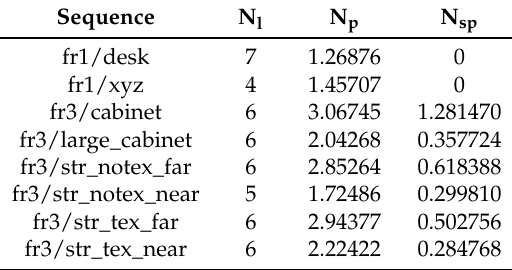
Table 4. The number of plane landmarks and the average number of observed planes on TUM RGB-D dataset. N l denotes the number of plane landmarks. N p denotes the average number of observed planes for every frame. The parameter N sp denotes the average number of supposed planes for every